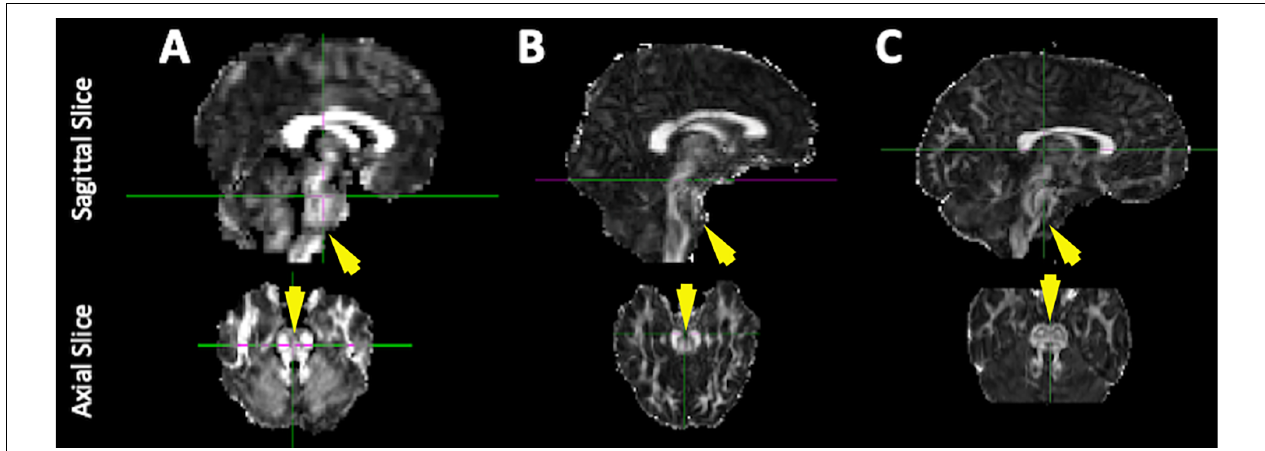
FIGURE 1 | Improvements to the quality of brainstem imaging through modifications to dMRI acquisition. Representative diffusion-weighted images from our previous work including the current conventional method. Example FA maps derived from dMRI scans (A) with low spatial resolution and no EPI distortion correction [used in Travers et al. (2015)], (B) with higher spatial resolution but no EPI distortion correction (collected between 2014 and 2016), and (C) with higher spatial resolution and EPI distortion correction (collected between 2016 and 2020, conventional processing